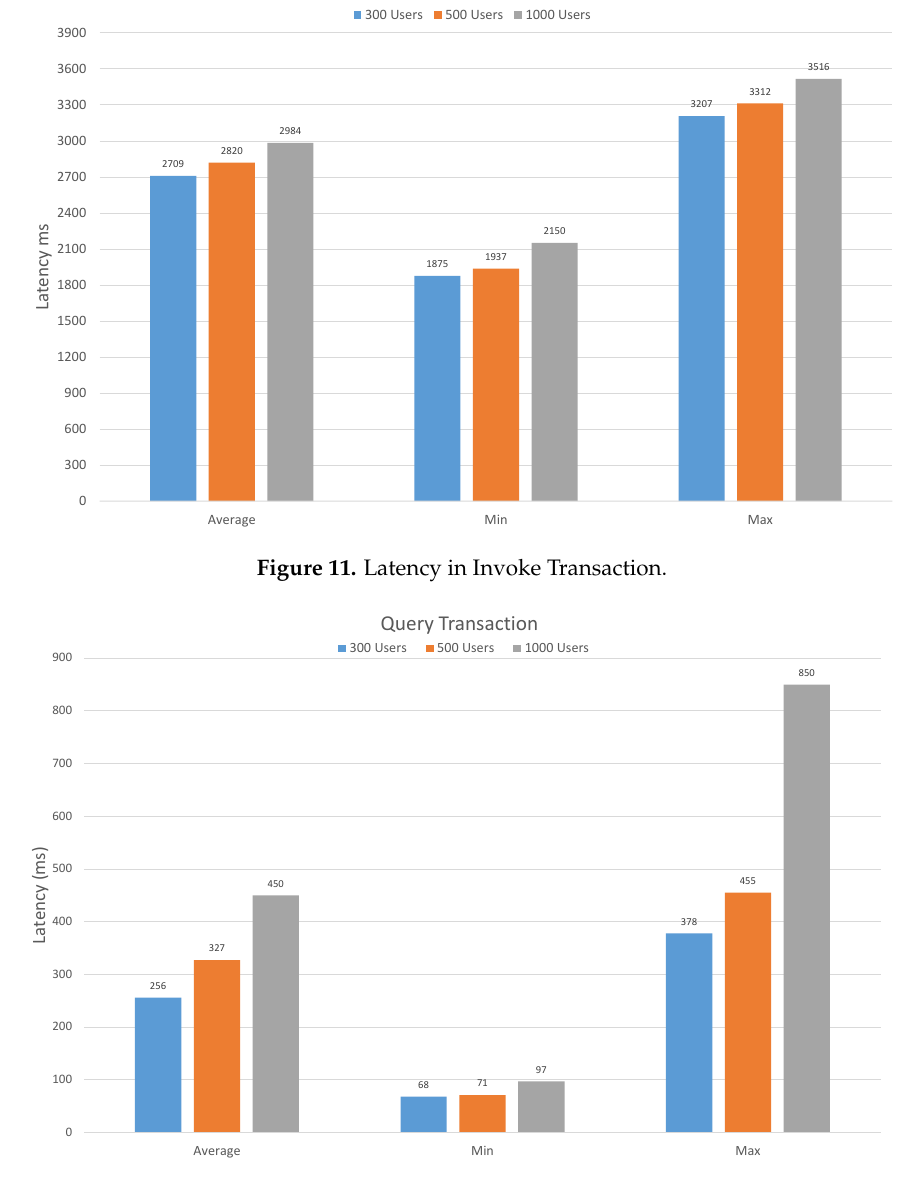
Figure 12. Latency in Query